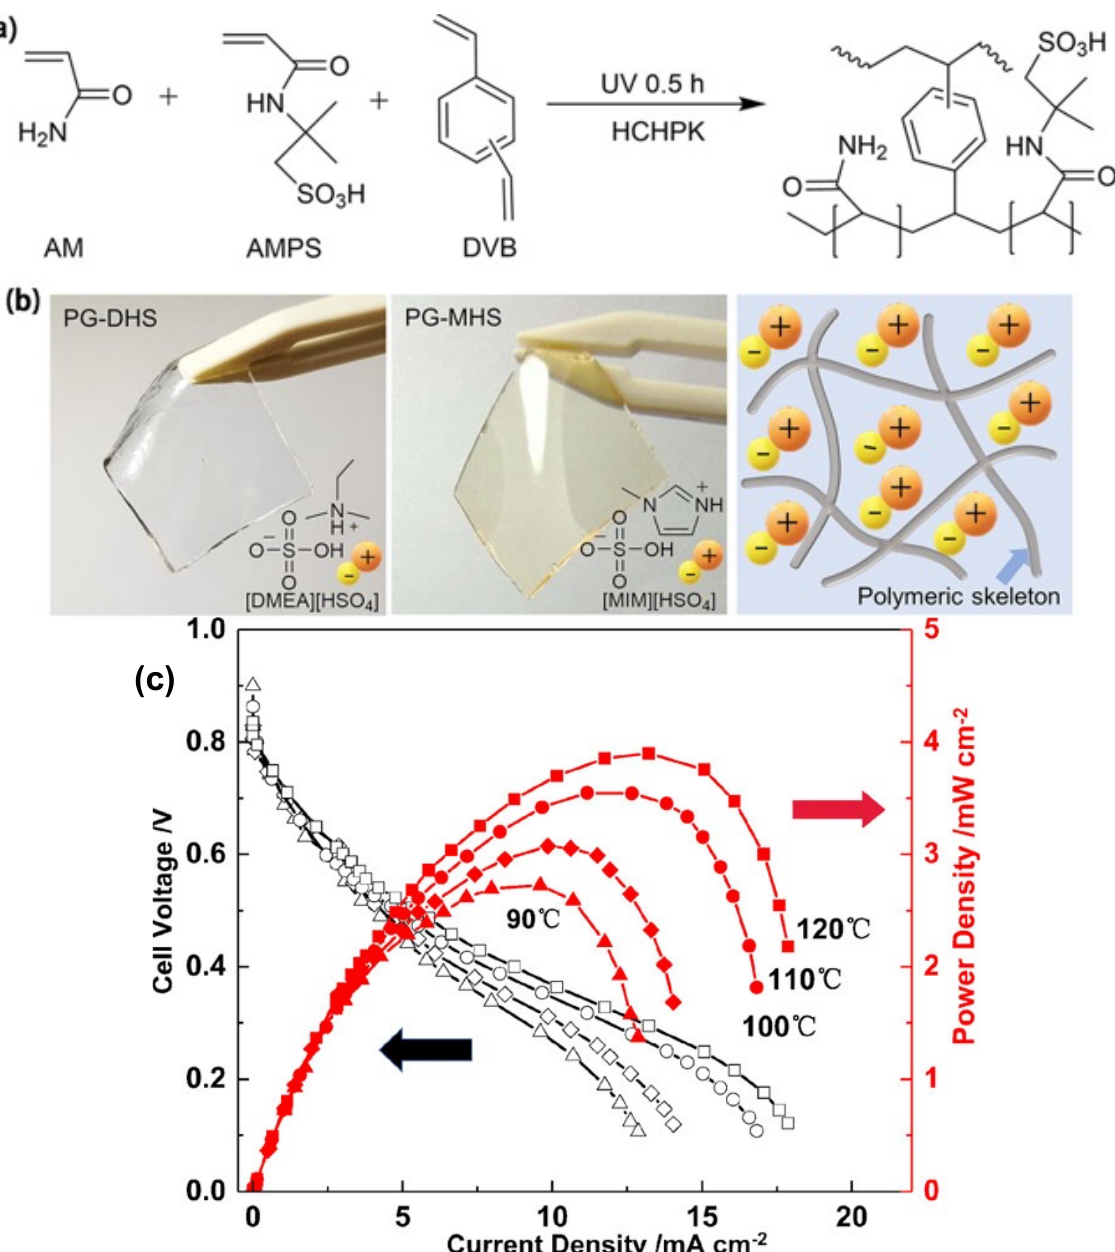
Figure 8. ( a ) Synthetic route of the polymeric skeleton, ( b ) the illustration of PG-DHS and PG-MHS IL-based gels, and ( c ) polarization curves of the H 2 /O 2 fuel cell prepared from PG-MHS at temperatures from 90 to 120 °C. Reprinted with permission from ref. [134].